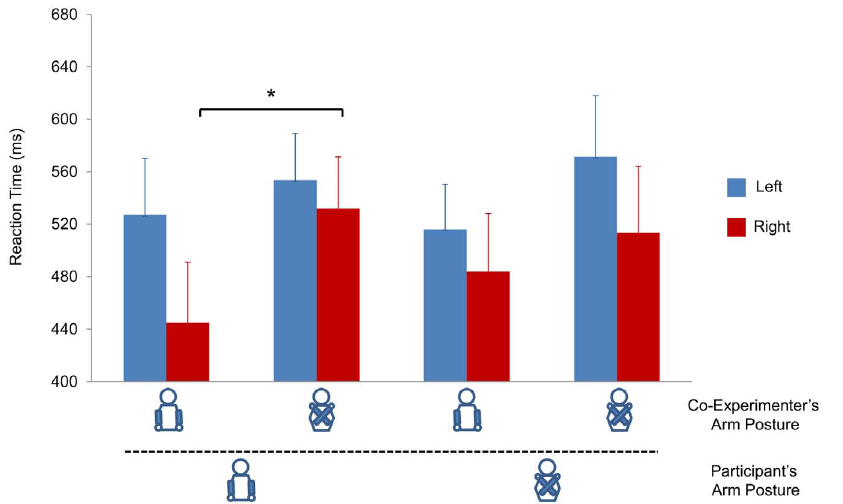
Figure 4. Results of Experiment 2 for left vs. right judgments. Graphical representation of the three-way interaction between Participant Arm Posture (uncrossed vs. crossed), Co-experimenter Arm Posture (uncrossed vs. crossed), and Response (left vs. right). Bars represent standard errors of the means. Asterisks indicate significance for the main contrasts of interest ( p , 05).